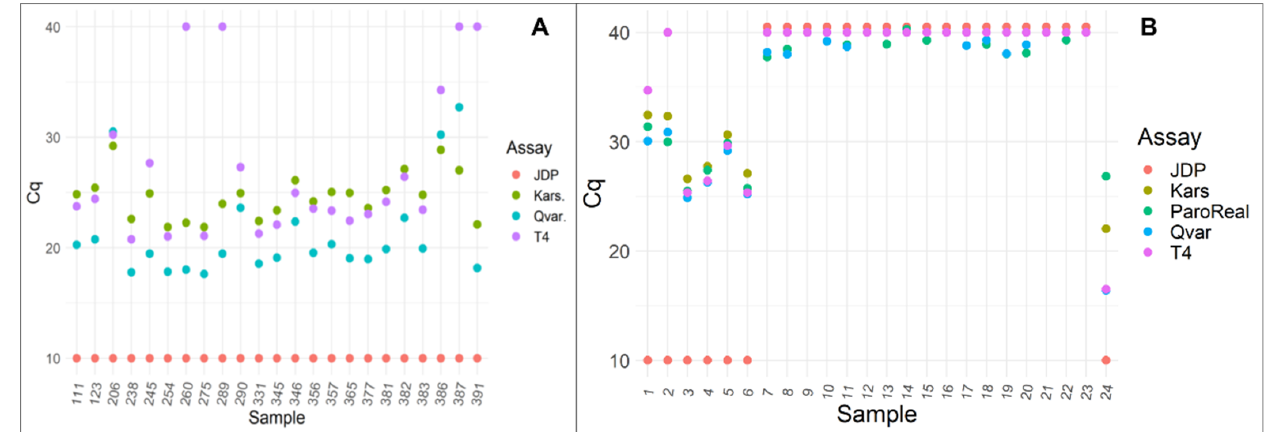
Figure 3. Cq values of positive corneal culture samples ( A ), and from direct clinical corneal samples ( B ). With a Cq cut off of 37 in ( B ), all methods (JDP, Qvar, Kars, and T4) present the same results, except for one sample that was not detected by the T4 assay and was found to be a T3 by sequencing. Dots represent the JDP positive samples with Cq values set at 10, while the negative samples are illustrated with dots at a Cq value of 40.